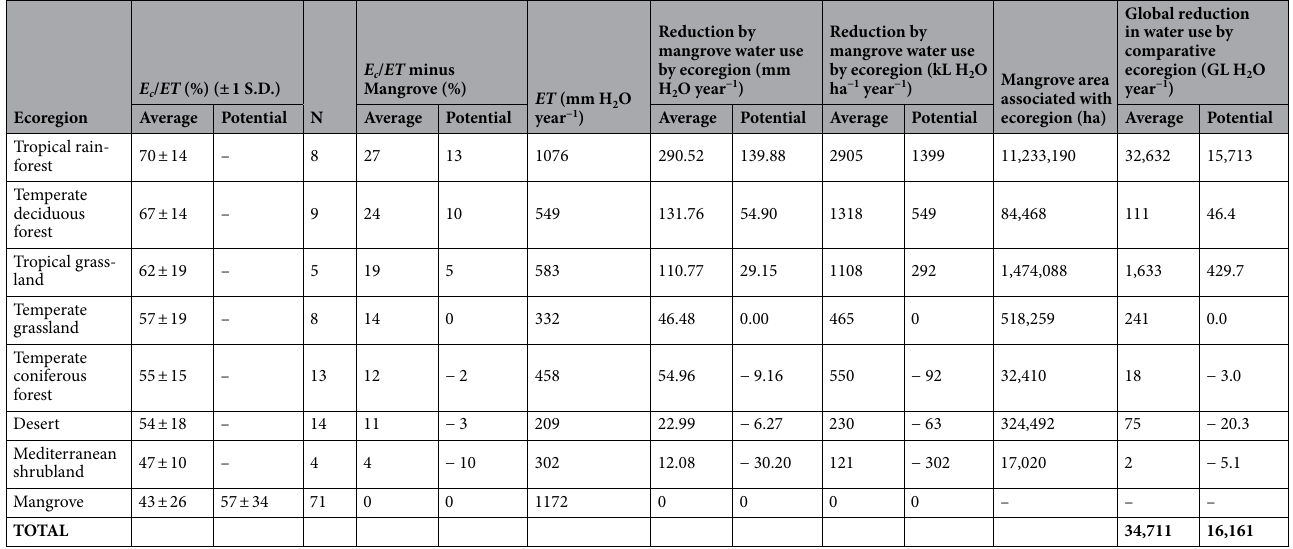
Table 1. Global summary of water use characteristics for mangrove forests versus the seven relevant ecoregional types reported by Schlesinger & Jasechko 48 . Canopy transpiration of dominant vegetation is abbreviated, E c , and regional evapotranspiration (from MODIS satellite) is abbreviated, ET . "Average" columns assume E c -to- ET ratios as they might occur under current stand conditions reported by the primary reference. "Potential" columns assume E c -to- ET ratios that might occur if mangrove porewaters freshen significantly versus average